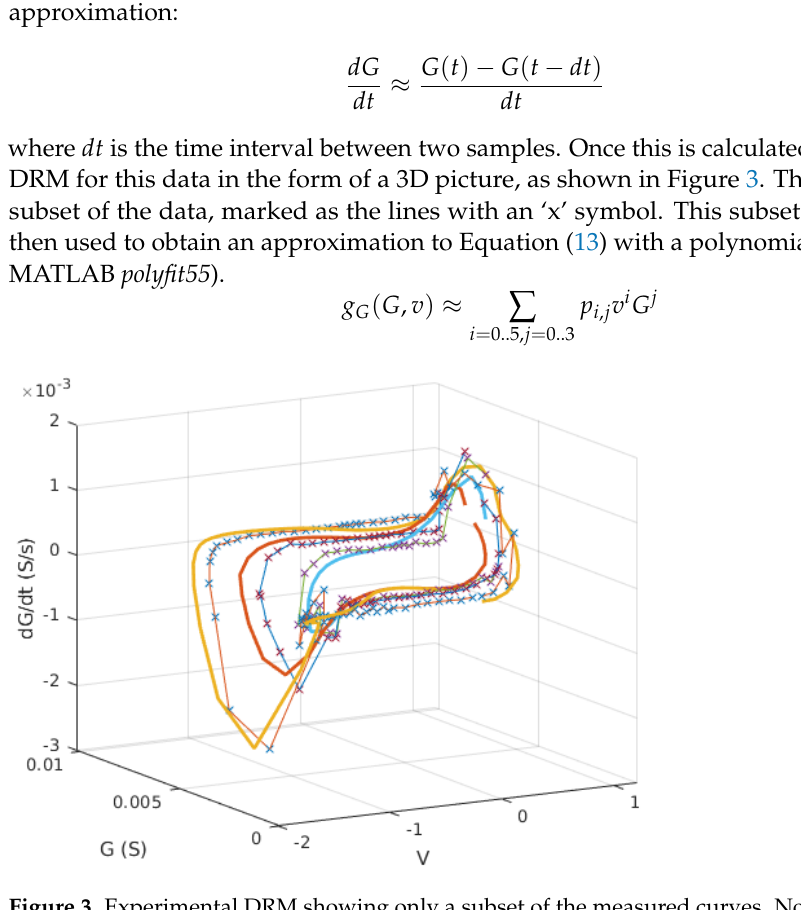
Figure 3. Experimental DRM showing only a subset of the measured curves. Notice that this figure can be reduced to Figure 2 if the dG/dt axis is ignored.